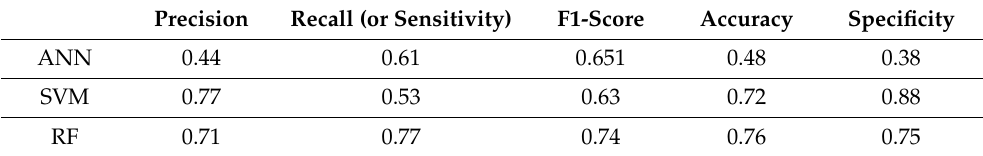
Table 6. Summary statistics for RF.